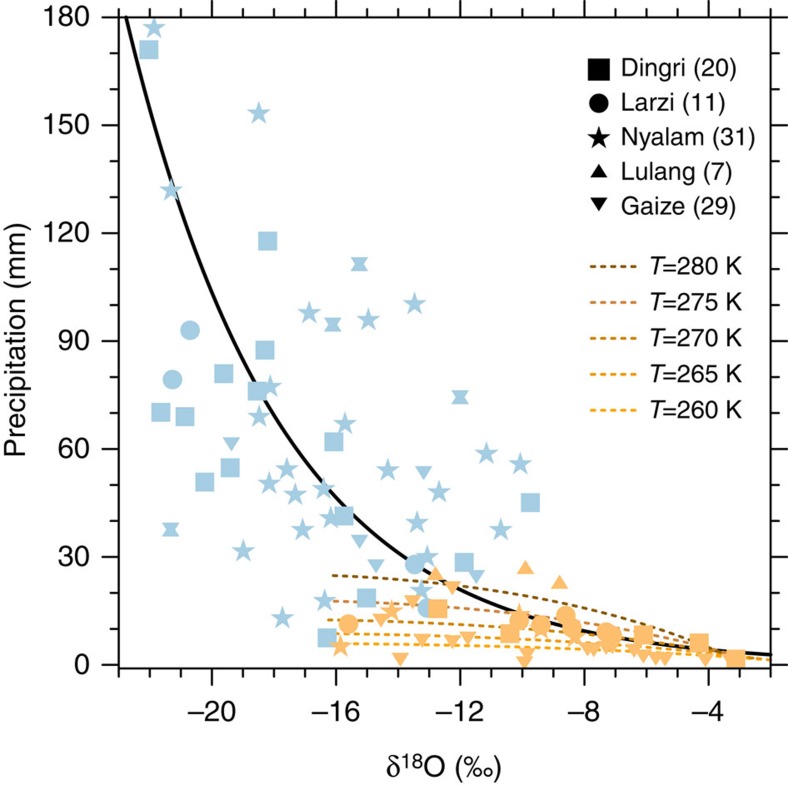
Isotopic content of precipitation.Scatter plot of summertime precipitation amount and δ18O in precipitation for 98 rainfall events at four TNIP observation stations and one ITP observation station during 1998–2007. Blue markers indicate values observed during intrusive CSs (59 events), while orange markers indicate value observed during non-intrusive CSs (39 events). The black solid line indicates the exponential trend line for all the markers. The coloured dashed lines indicate theoretical estimates of the amount effect in local convection with different initial temperature (ranges from 260 to 280 K) calculated by isotope theoretical model.